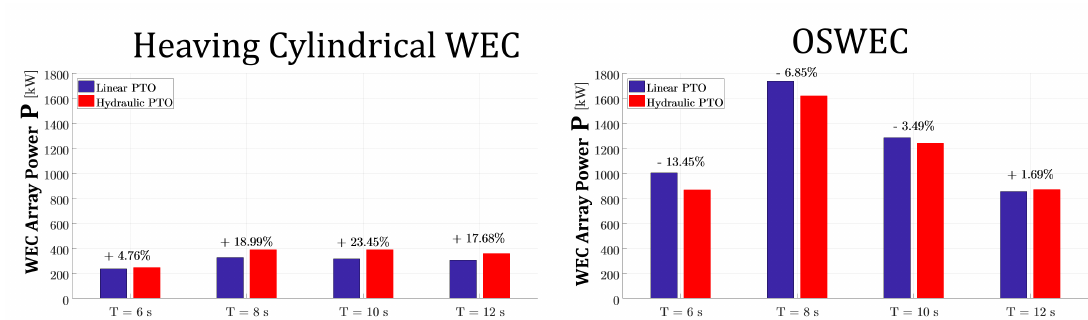
Figure 13. Bar chart showing the power output for a 5-WEC heaving cylindrical WEC array ( left ) and OSWEC array ( right )with linear PTO system (purple) and hydraulic PTO system (red) with the percentage difference between the two calculated by Equation